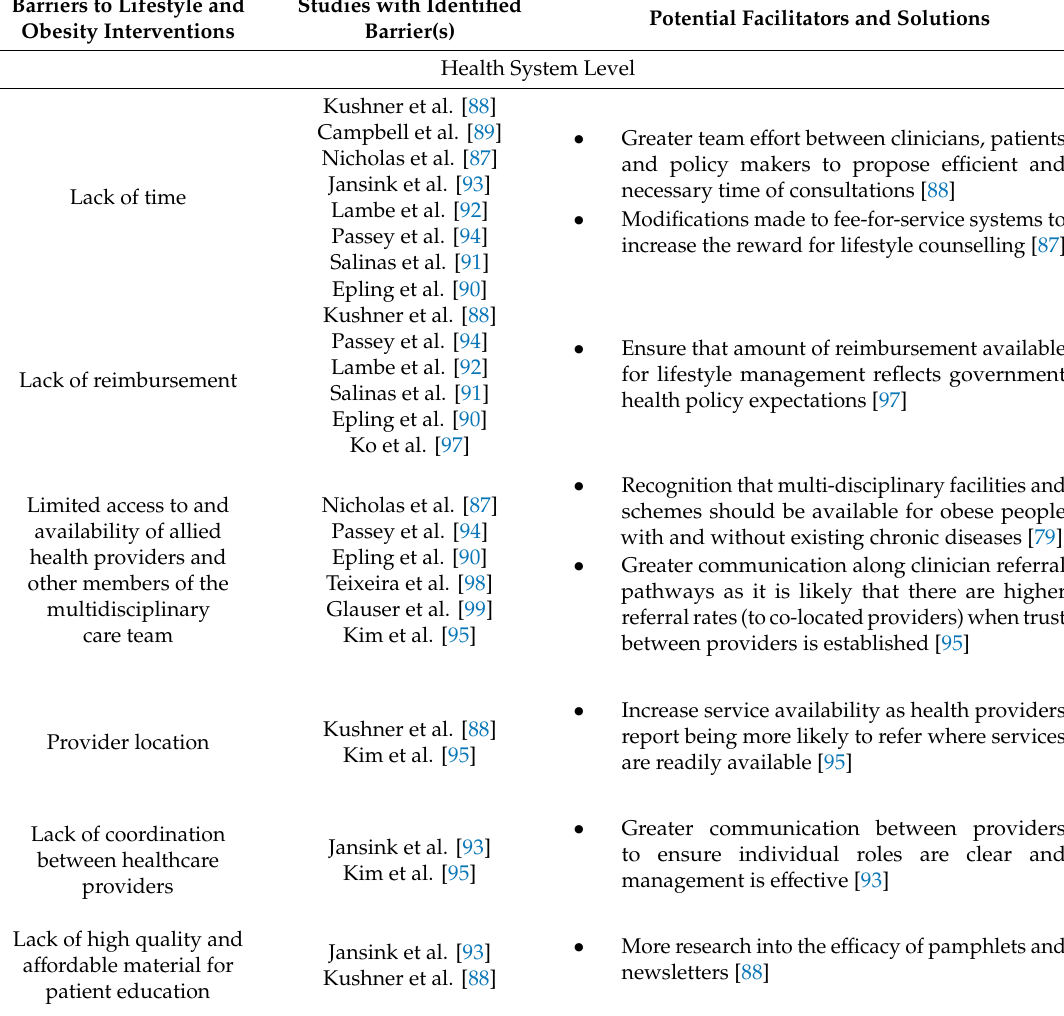
Table 2. A summary of key barriers to implementation of lifestyle interventions experienced by healthcare professionals at the level of the health system and the